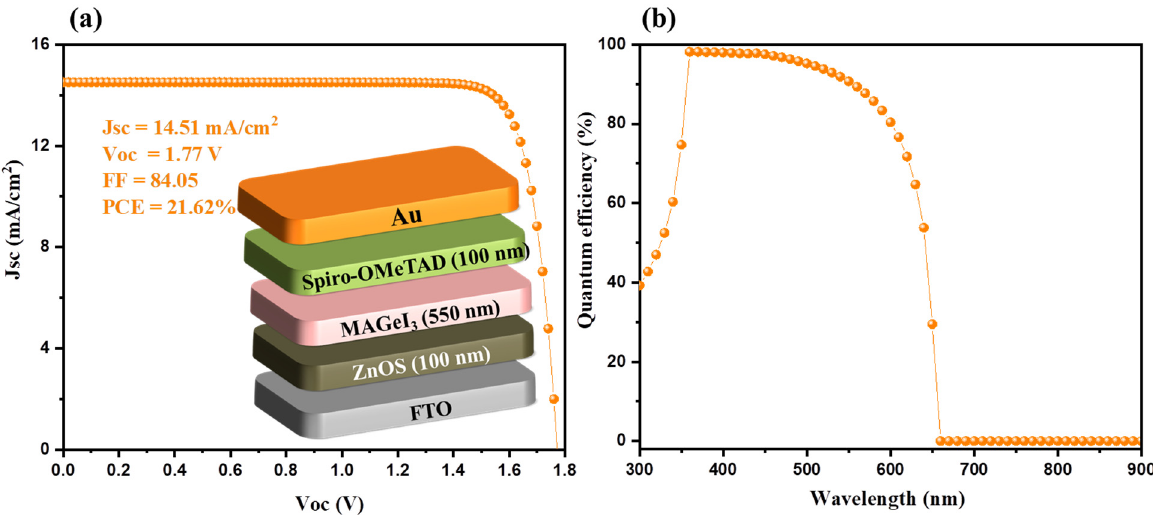
Figure 8. J-V curve ( a ) and EQE curve ( b ) of the optimized, best-performing Pb-free PSCs (FTO (500nm)/ZnOS(100 nm)/MAGeI 3 (550 nm)/spiro-OMeTAD(100 nm)). The inset of Figure 1a shows the optimized device structure.